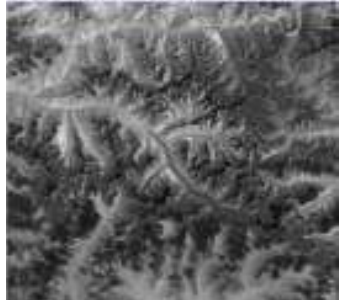
Figure 1. Landsat TM5, 1990 Band 6 image of study area